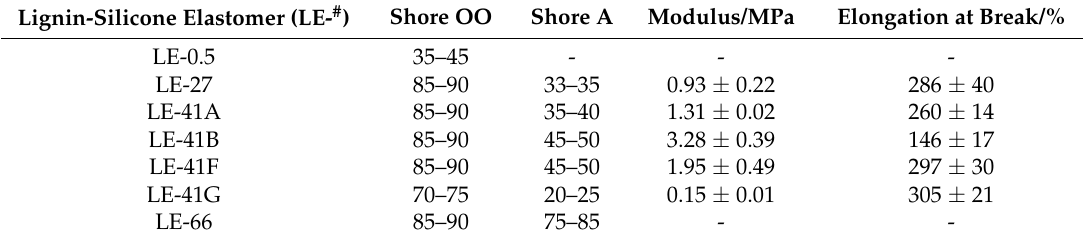
Table 2. Mechanical properties of lignin-silicone composites (Summarized from Reference [37]). Lignin-Silicone Elastomer (LE- # ) Shore OO